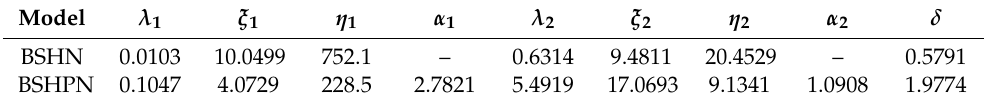
Table 4. Parameter estimates for BSHN and BSHPN